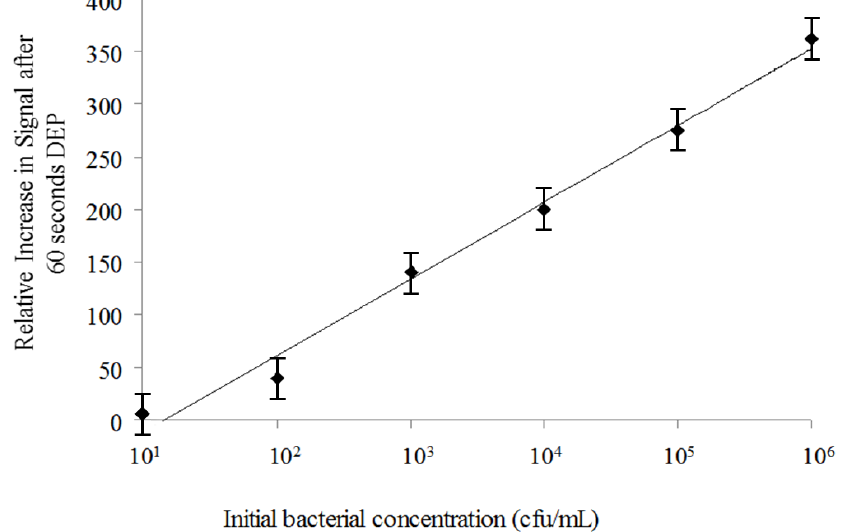
Figure 5. Concentration of serial bacterial dilutions after sixty seconds of dielectrophoresis (DEP). Signal increases with initial bacterial concentration in the range of 10 1 –10 6